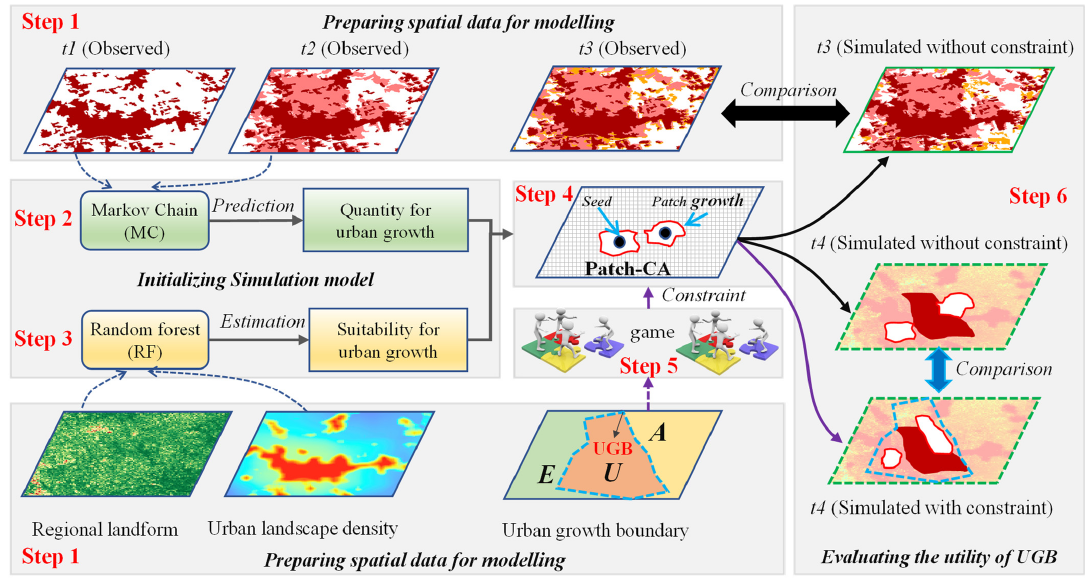
Figure 1. Procedure for evaluating the utility of UGB with CUGSM.